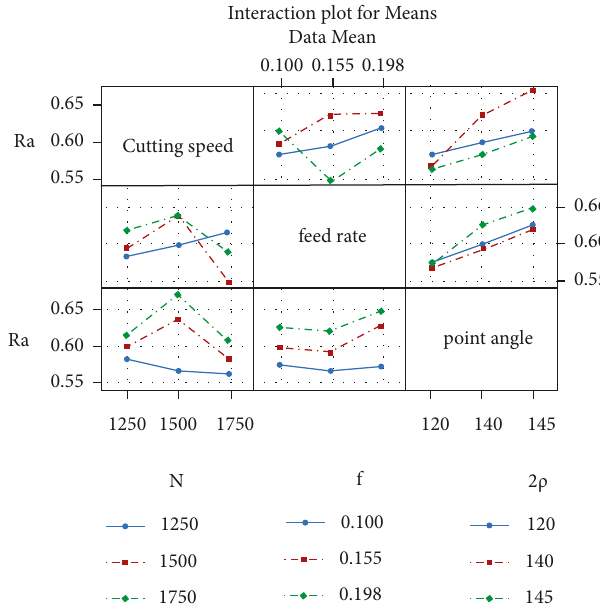
Figure 5: Interaction plot for means: cutting